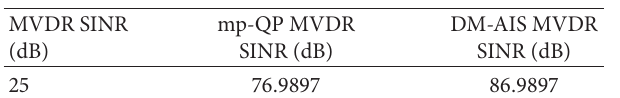
Figure 6: Comparison among DM-IS, mp-QP MVDR, and MVDR of one user at 0 ∘ and interference 40 ∘ and − 40 ∘ . Table 5: Illustration of the SINR for DM-AIS, mp-QP MVDR, and